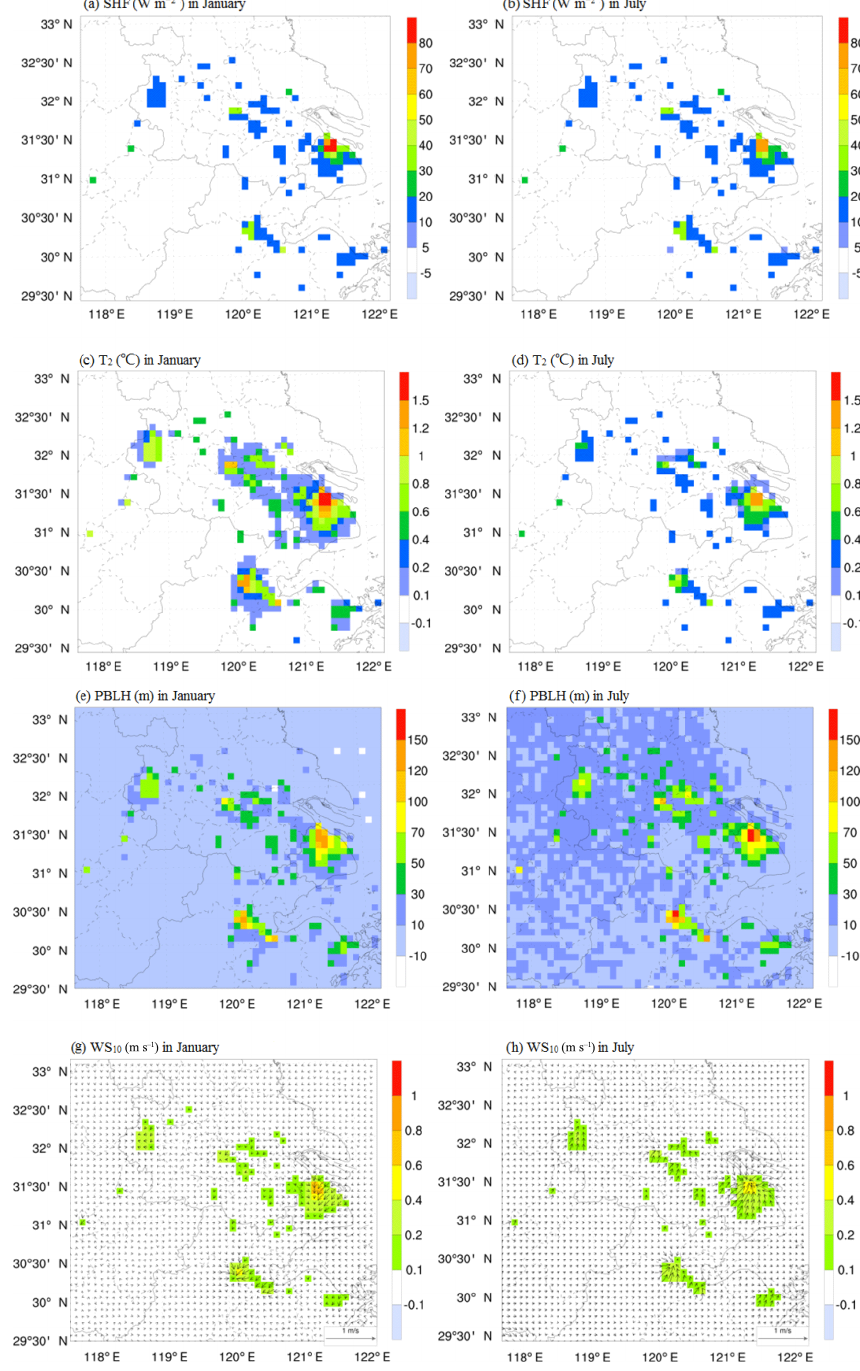
Figure 6. The spatial distributions of monthly averaged differences for sensible heat flux (SHF), air temperature at 2m ( T 2 ), the height of the planetary boundary layer (PBLH), and wind speed (WS 10 ) at 10m between ADDAH and NONAH (ADDAH-NONAH). Panels (a) , (c) , (e) and (g) show changes in January. Panels (b) , (d) , (f) and (h) illustrate variations in July. The arrows in panels (g) and (h) are the differences of wind fields. Differences that are non-significant under the 95% confidence level (Student’s t test) are masked